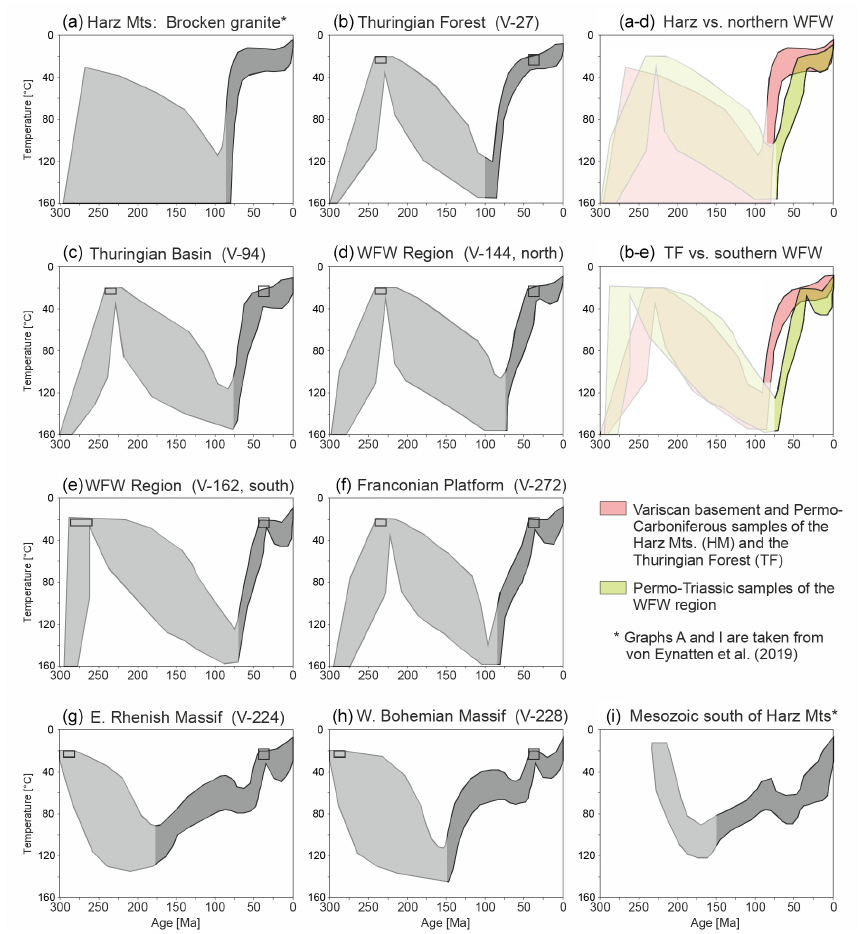
Figure 9. Time–temperature ( tT ) plots showing the envelopes of the good results of the modelling series performed on selected samples from the different regions. The modelling has been performed by HeFTy software (Ketcham, 2005) using the AFT data. Only tT paths classified as good fits by the programme are considered. The dark grey sections represent the well-constrained intervals of the cooling histories, while the light grey fields indicate the time–temperature regime where the modelling results carry insignificant information, as these ranges are older than the oldest fission tracks in the samples. Grey boxes indicate the time–temperature constraints when the dated samples experienced surface temperature conditions. The graphs in the upper right emphasize the contrast in the post-climax cooling paths between the exhumed basement blocks (a, b) and the Permo-Triassic of the WFW core region (d, e) .